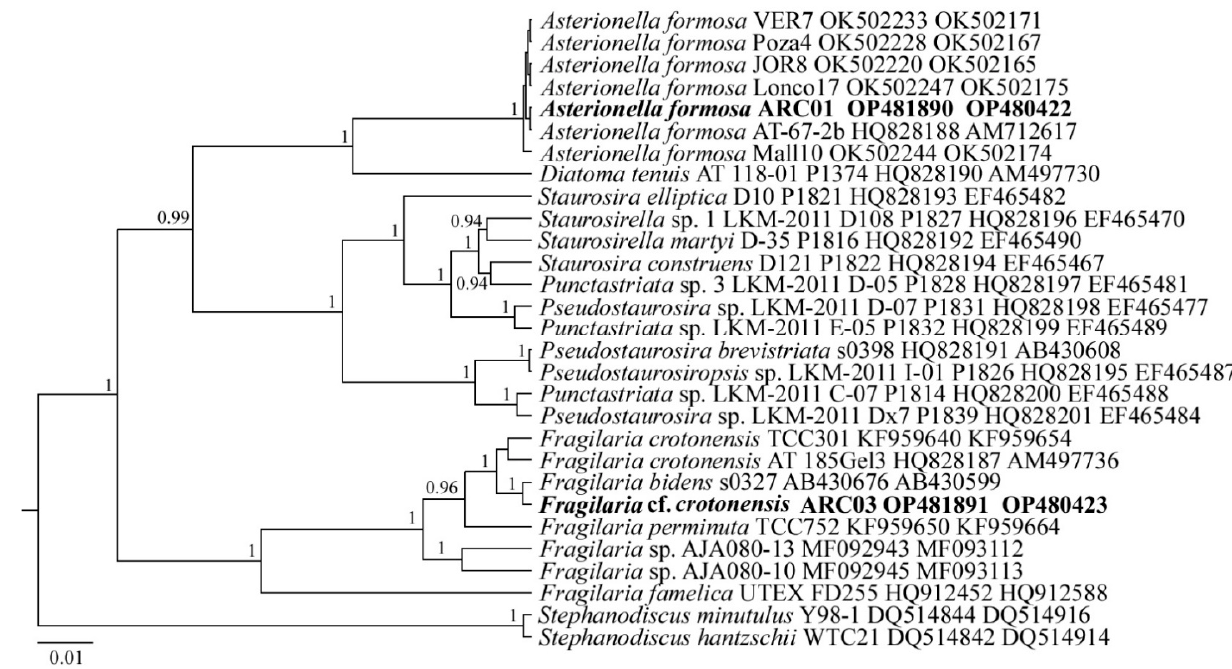
Figure 6. Phylogenetic position of strains Asterionella formosa ARC01 and Fragilaria cf. crotonensis ARC03 (indicated in bold) based on Bayesian inference for the partial 18S rRNA and rbcL genes. Total length of the alignment is 1446 characters. Posterior probabilities exceeding 0.9 of BI (constructed by Beast) are presented in order on the nodes. Strain numbers (if available) and GenBank numbers are indicated for all sequences.